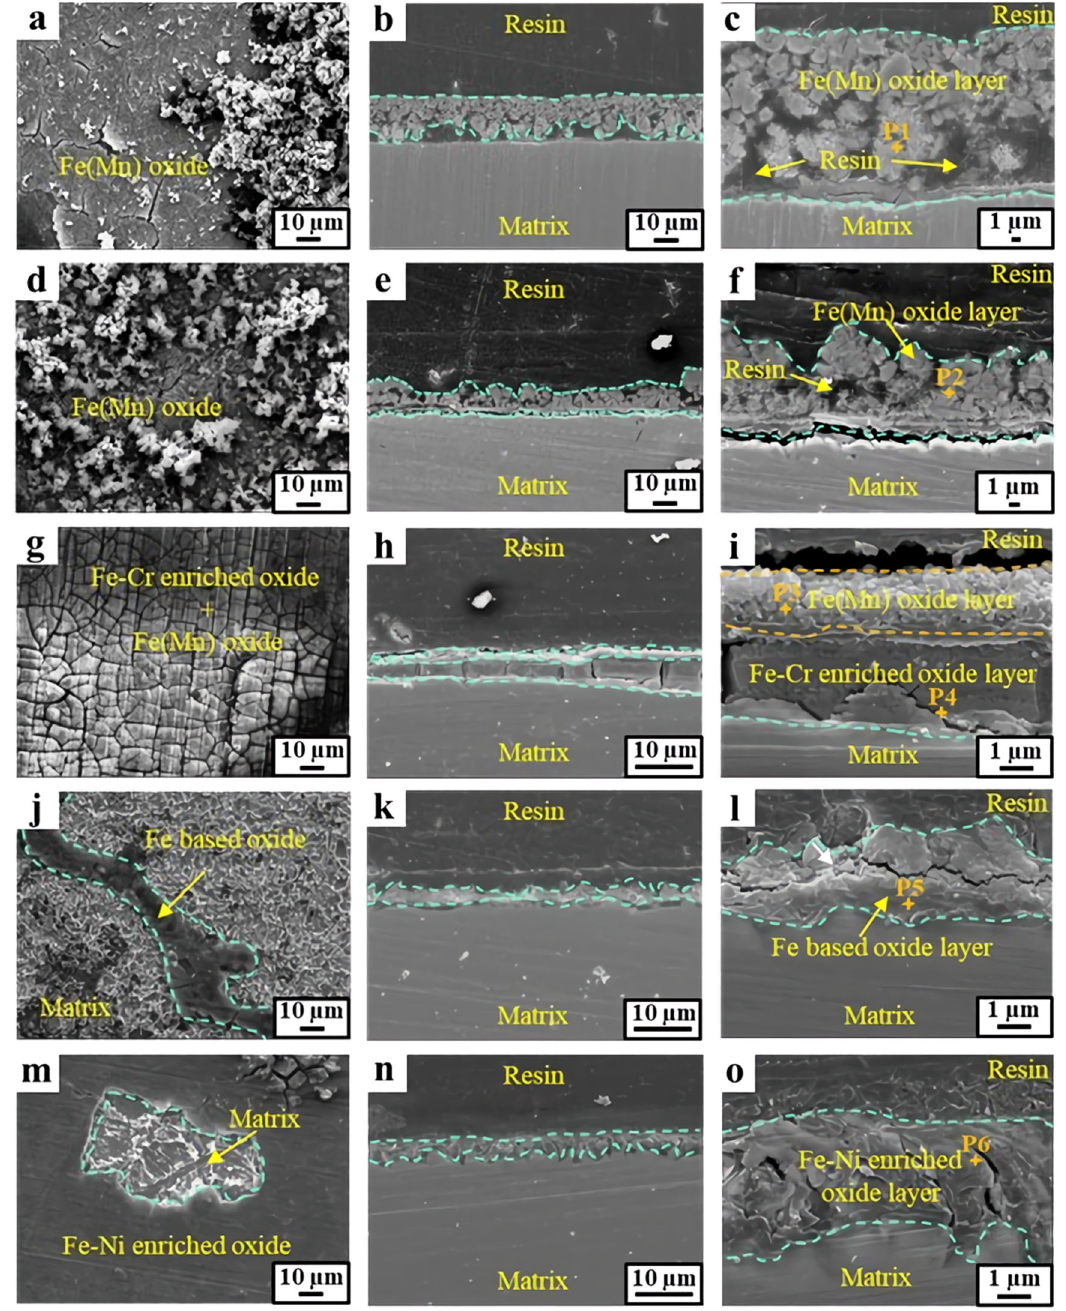
Fig. 3 FE-SEM images of the samples (28 days of immersion in a 3.5% NaCl solution). a , b Surface and cross-section images of M_Mn, respectively. c Magni fi ed view of b . d , e Surface and cross-sectional images of H_Mn, respectively. f Magni fi ed view of e . g , h Surface and cross- sectional images of H_Mn-L_Cr, respectively. i Magni fi ed view of h . j , k Surface and cross-sectional images of API X70, respectively. l Magni fi ed view of k . m , n Surface and cross-sectional images of 9Ni, respectively. o Magni fi ed view of n